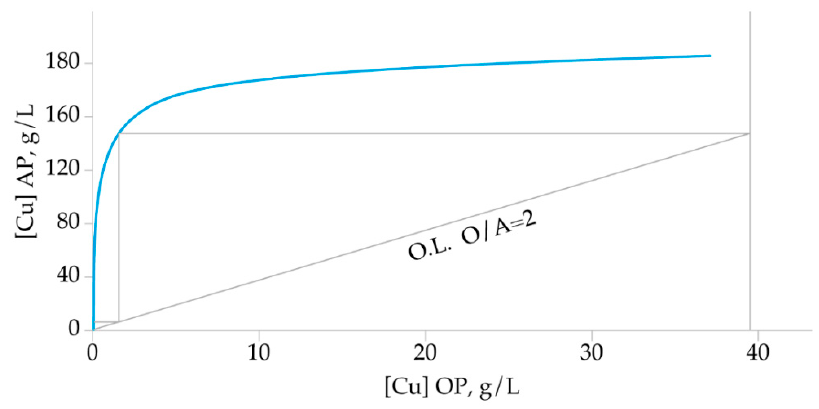
Figure 11. McCabe-Thiele stripping